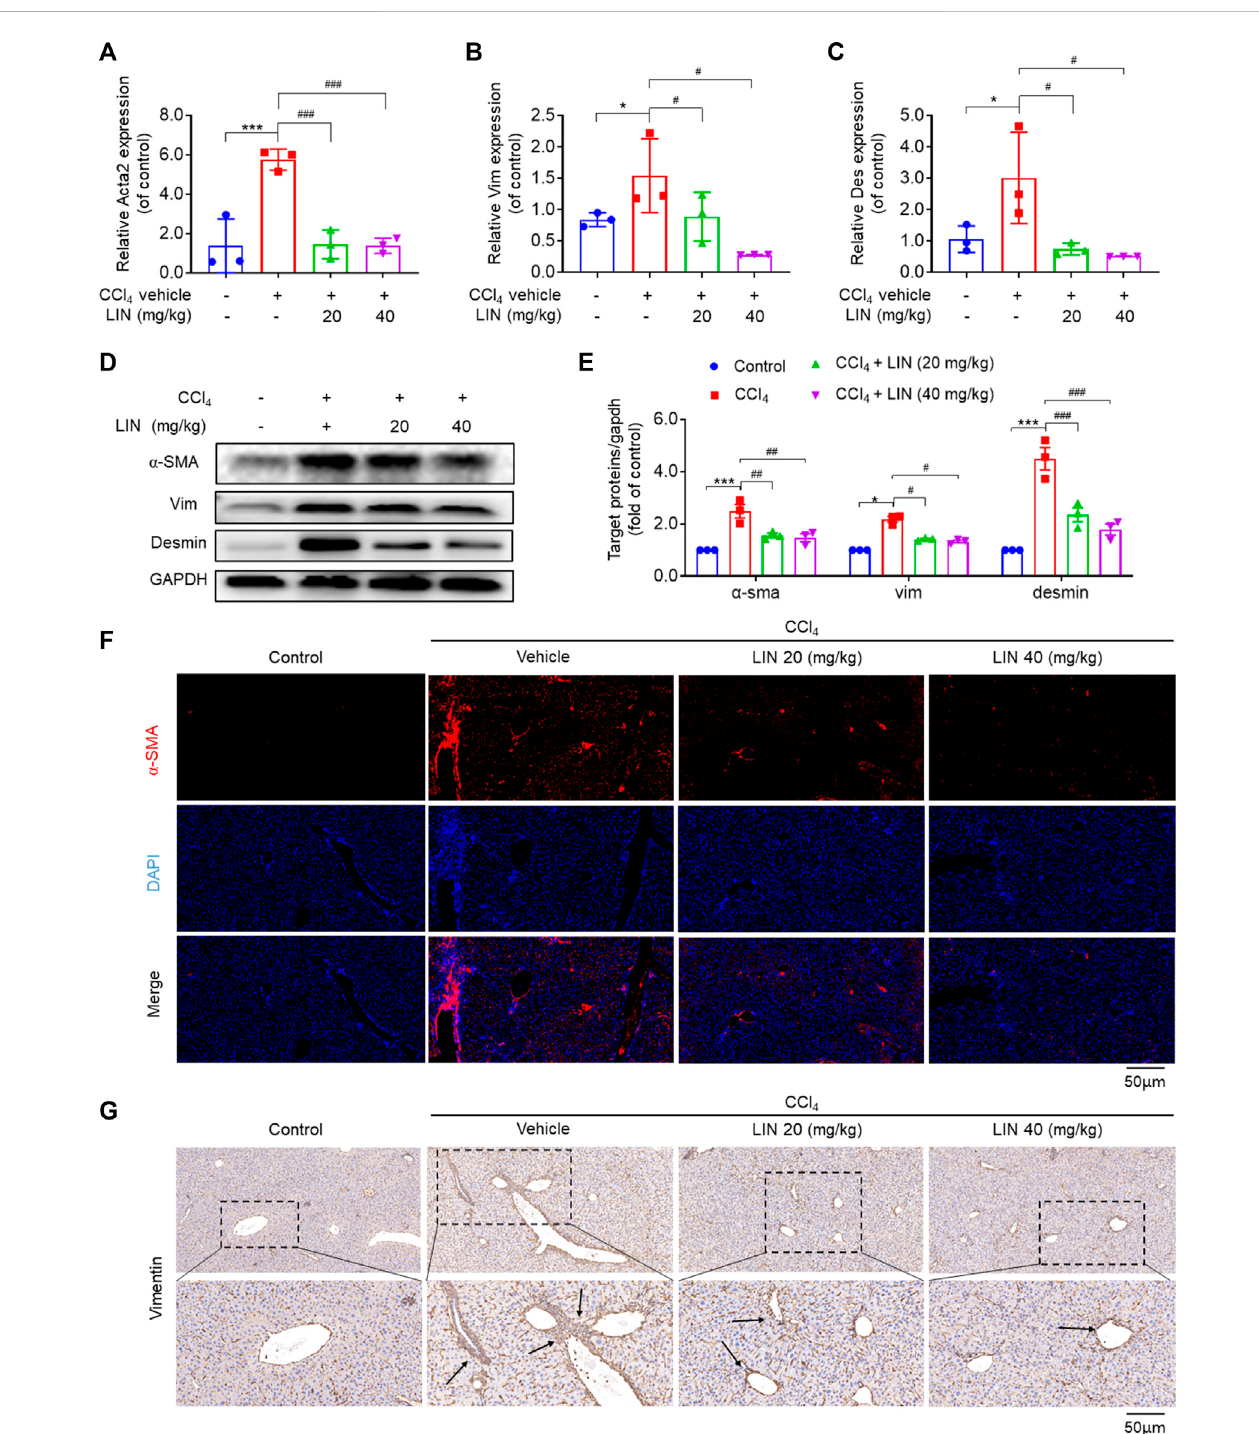
FIGURE 5 LIN inhibited HSCs activation in CCl 4 -treated mice. (A – C) Hepatic Acta2 ( α -SMA), Vim (Vimentin), Des (Desmin) mRNA expression ( n = 3). (D) The expression ofliver α -SMA, vimentin, and desmin proteinweredetected byWestern-blot,and GAPDH wasusedas aloading control. (E) The quantitative result of α -SMA, vim, and desmin. The results represent three independent experiments. (F) Liver α -SMA immuno fl uorescence staining (original magni fi cation × 100). (G) Liver Vimentin immunohistochemical staining. Representative images are chosen from each experimental group. Data were expressed